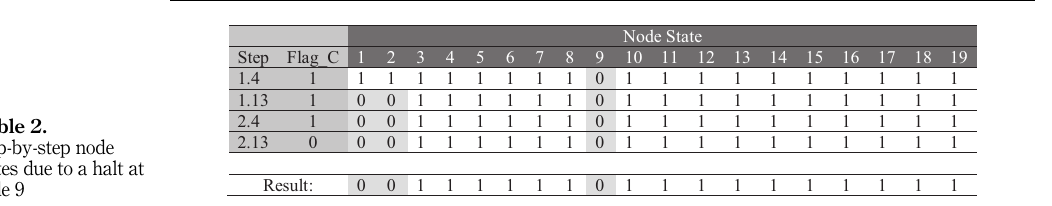
Table 2. Step-by-step node states due to a halt at node